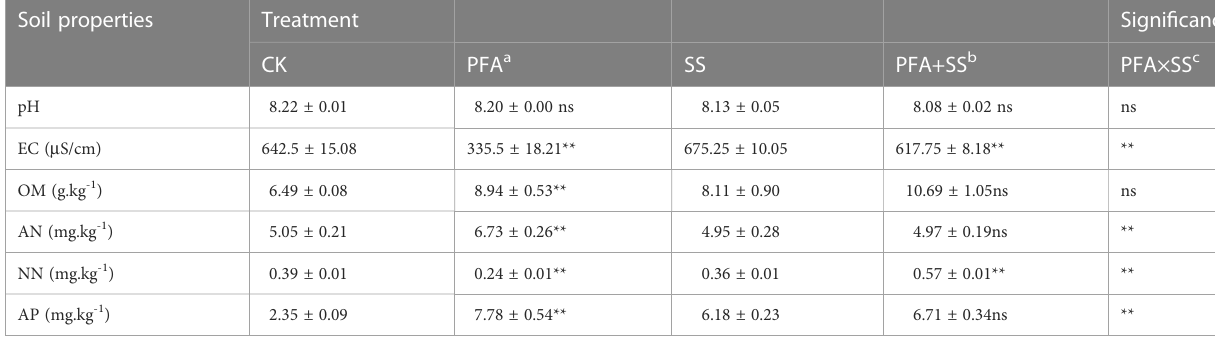
TABLE 1 Effect of PFA on the rhizosphere soil properties of the seedlings.